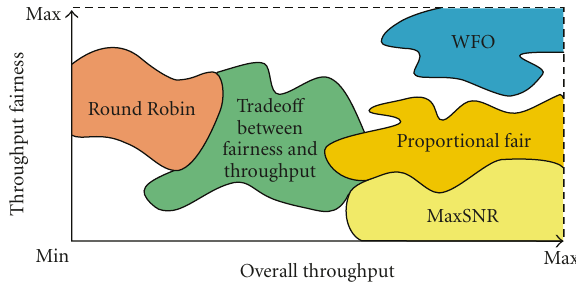
Figure 1: Tradeo ff between overall throughput and fairness.